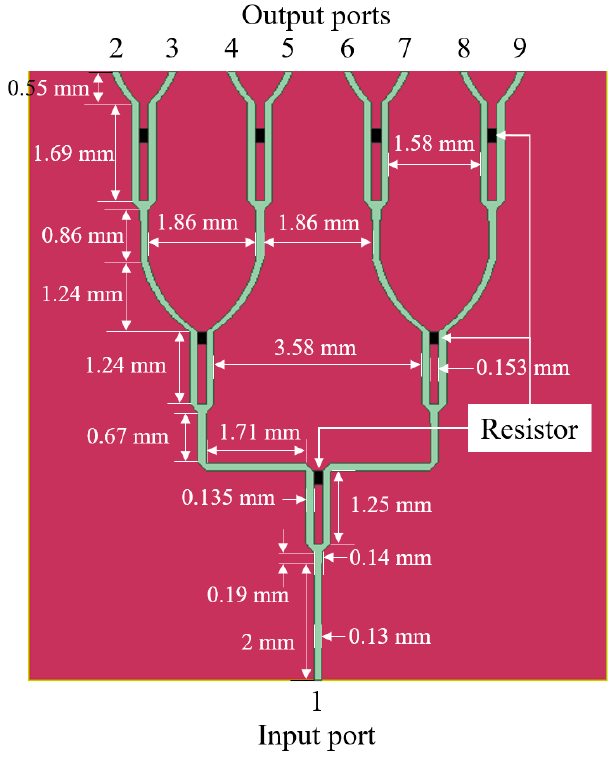
Figure 6. Schematic of one-by-eight 50 Ω Wilkinson power divider.